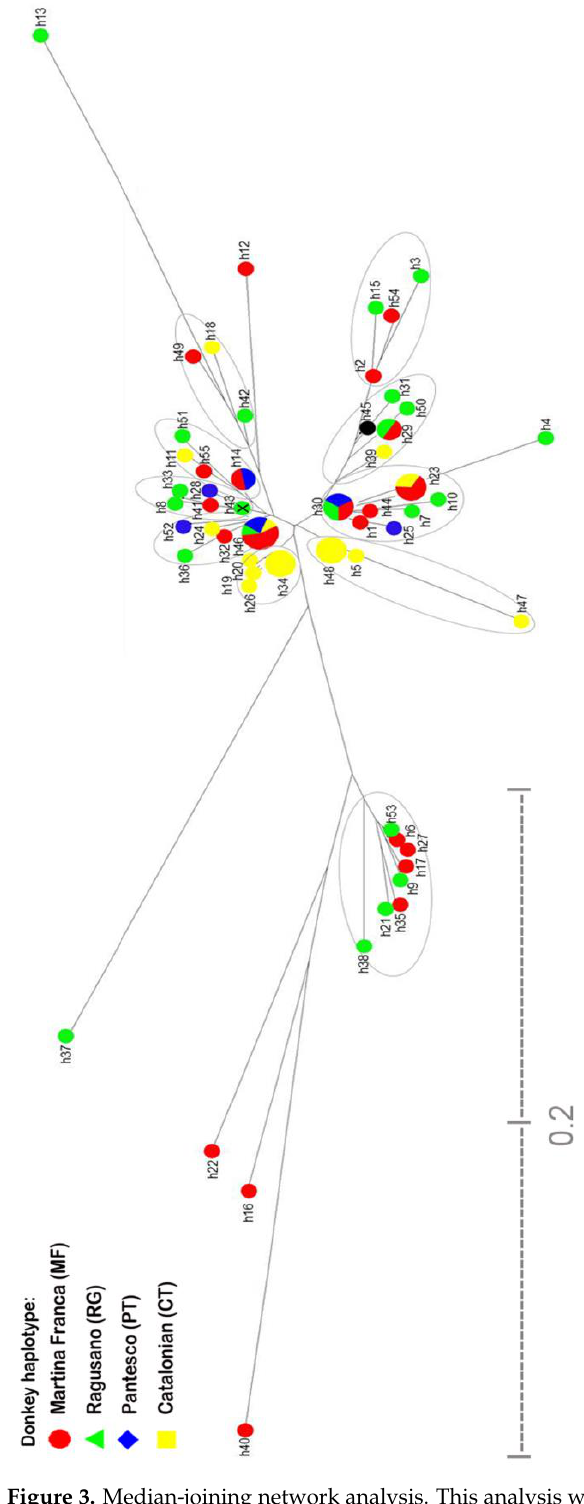
Figure 3. Median-joining network analysis. This analysis was based on 350 bp of the mtDNA D- loop sequences of 77 donkeys (Martina Franca (MF), Ragusano (RG), Pantesco (PT), Catalonian (CT)), which consists of 55 haplotypes (DARwin 6.0). Each breed is color coded, and for each hap- lotype, the proportions of the different breeds are shown, in black the crossbreed haplotype. The reference sequence X97337 is indicated as x.